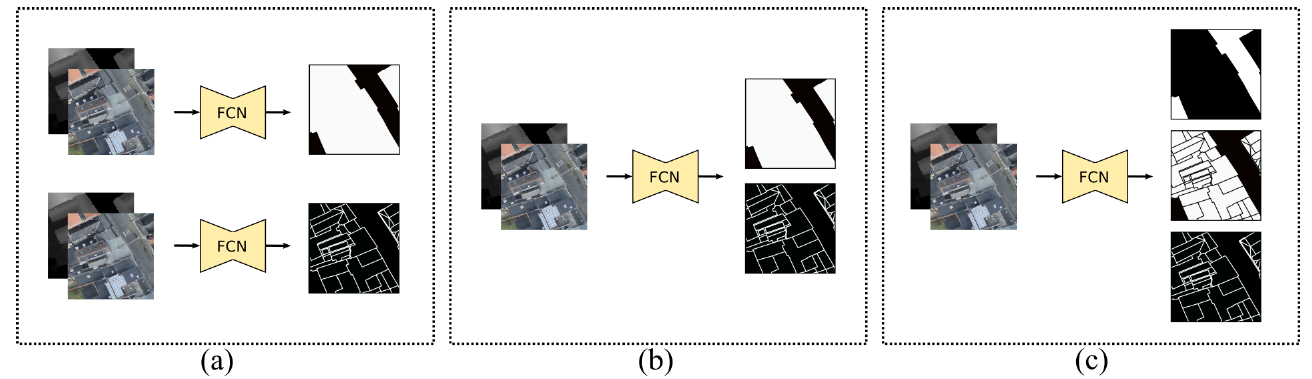
Figure 5. Comparison of modelling approaches using a fully convolutional network (FCN). All approaches take an RGB and/or DEM image patch as input and return a roof-part object and edge probability map. ( a ) Separate models for roof and roof-part edge segmentation. ( b ) Single multilabel model. ( c ) Single multiclass